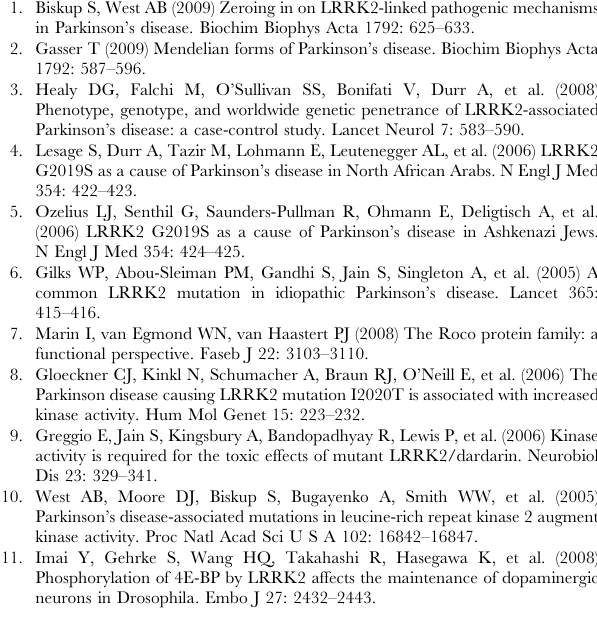
Figure S7 Silencing of ArfGAP1 expression with lentiviral sh- ArfGAP # 1 rescues G2019S LRRK2-induced neurite shortening. (A) Silencing of endogenous ArfGAP1 expression in